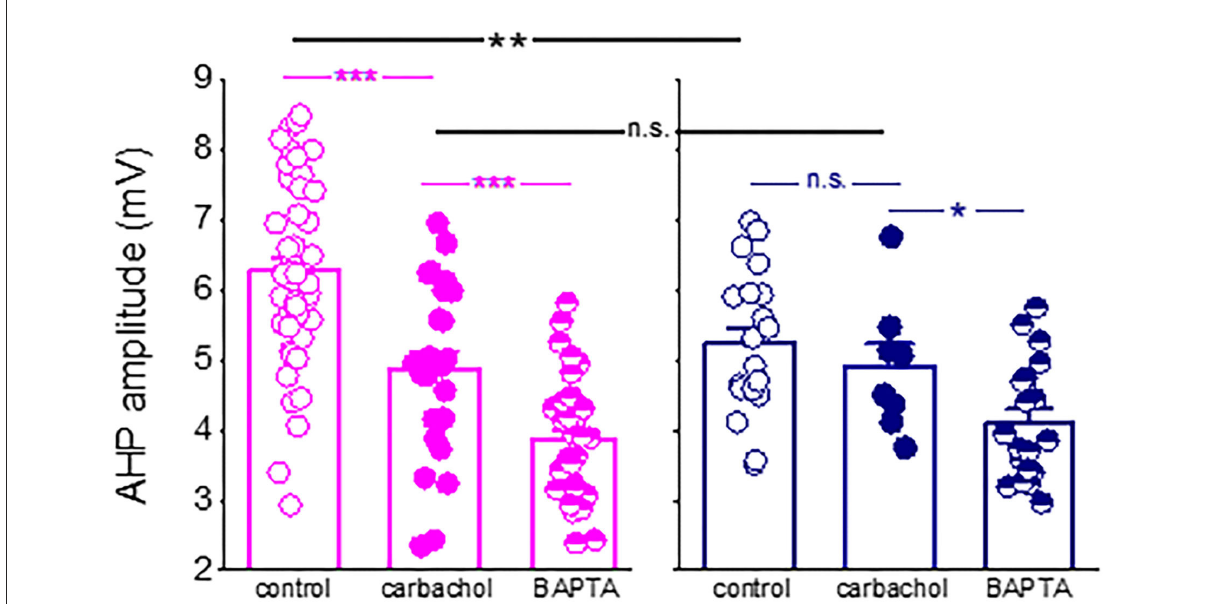
FIGURE7 Difference in the post-burst AHP amplitude between neurons from control and trained rats is abolished in the presence of a cholinergic agonist. Application of the cholinergic agonist, carbachol, reduced significantly the post-burst AHP amplitude in neurons from control rats ( P < 0.001) but did not affect the post-burst AHP in neurons from trained rats. Moreover, in the presence of the agonist, the difference in the post-burst AHP amplitude between the two groups ( p < 0.01) was abolished. Notably, intracellular application of the calcium chelator BAPTA via the recording electrode (Saar et al., 2001) further reduced the post-burst AHP in neurons from control and trained rats. Bars represent mean ± SE. Each point reorients the post-burst AHP value in a cell. All data are taken from our previous publication (Saar et al., 2001). The unpaired t -test was used to examine the difference between neurons from trained and control rats and between neurons from the same groups at different conditions. * p < 0.05; ** p < 0.01; *** p < 0.001; n.s., not